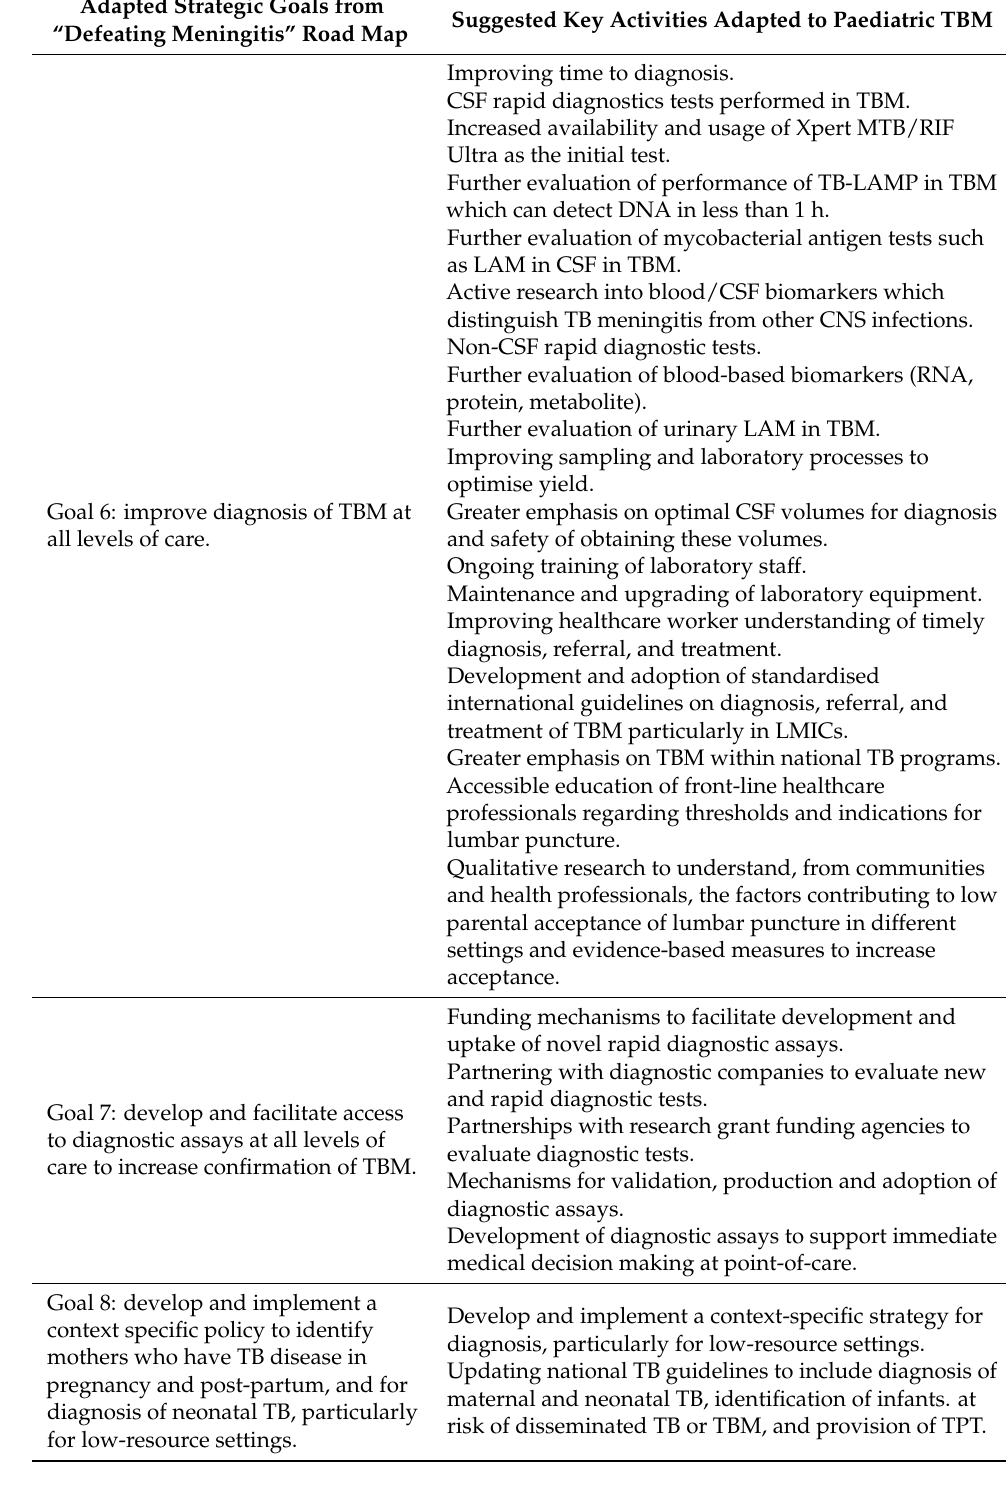
Table 3. Selected relevant strategic goals reproduced from Pillar 2 the “defeating meningitis” roadmap and suggested paediatric TBM-related activities